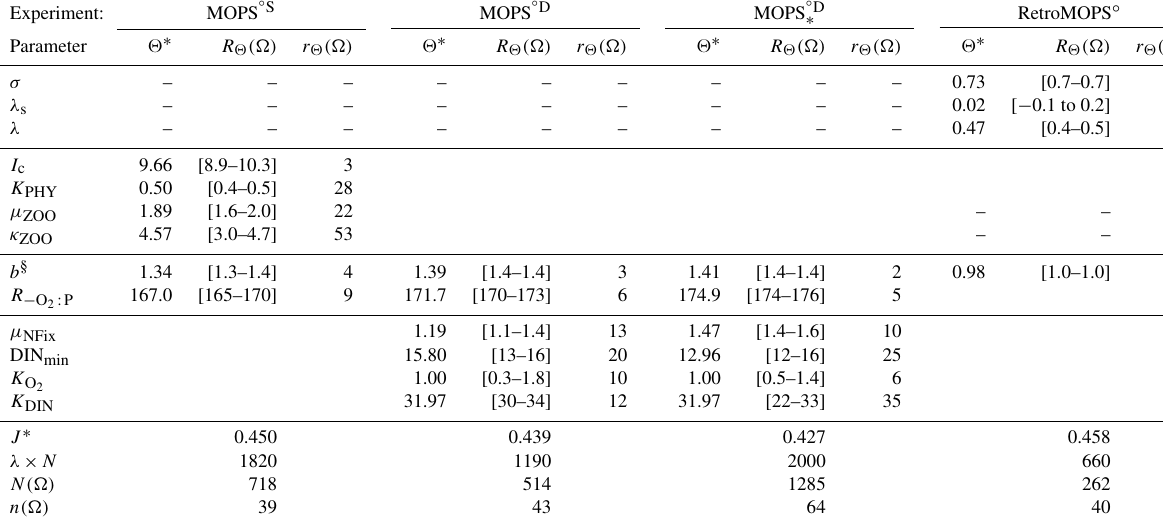
Table 3. Optimisation results: minimum misfit J ∗ , optimum parameters and their uncertainties. To determine parameter uncertainty, we selected a group (cid:127) of the 1‰ best individuals, i.e. individuals defined by a misfit J i : J i /J ∗ − 1 ≤ (cid:49) J , with (cid:49) J = 0 . 001. The number of these individuals N((cid:127)) is also denoted as fraction n((cid:127)) of all individuals of the optimisation λ × N , where N is the number of generations, and λ = 10 the population size. For each parameter (cid:50) the first column gives the optimal parameter (cid:50) ∗ (i.e. the average parameter of the last generation). The second and third column present the parameter range of all individuals of (cid:127) , expressed as absolute value ( R (cid:50) ((cid:127) )), and normalised by the a priori range of parameters ( R A ; see Table 1): r (cid:50) ((cid:127)) = R (cid:50) ((cid:127))/R A value. (cid:50) (cid:50)